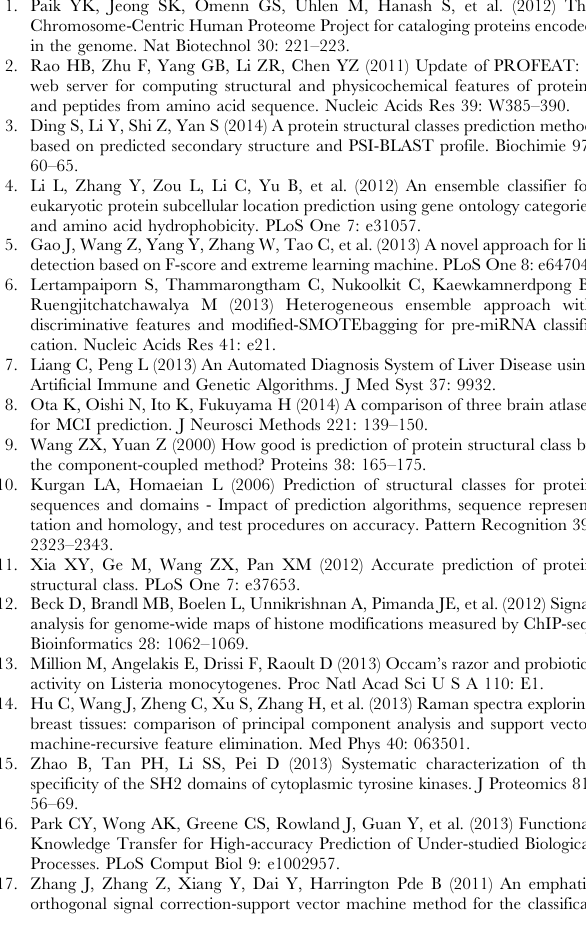
Figure S2 The ROC curves for 25PDB dataset. Figure S3 The ROC curves for Z277 dataset. Figure S4 The ROC curves for Z498 dataset. Figure S5 The ROC curves for D1185 dataset. Figure S6 The ROC curves for D8244 dataset. (TIF) Datasets S1 Seven datasets used in this study.